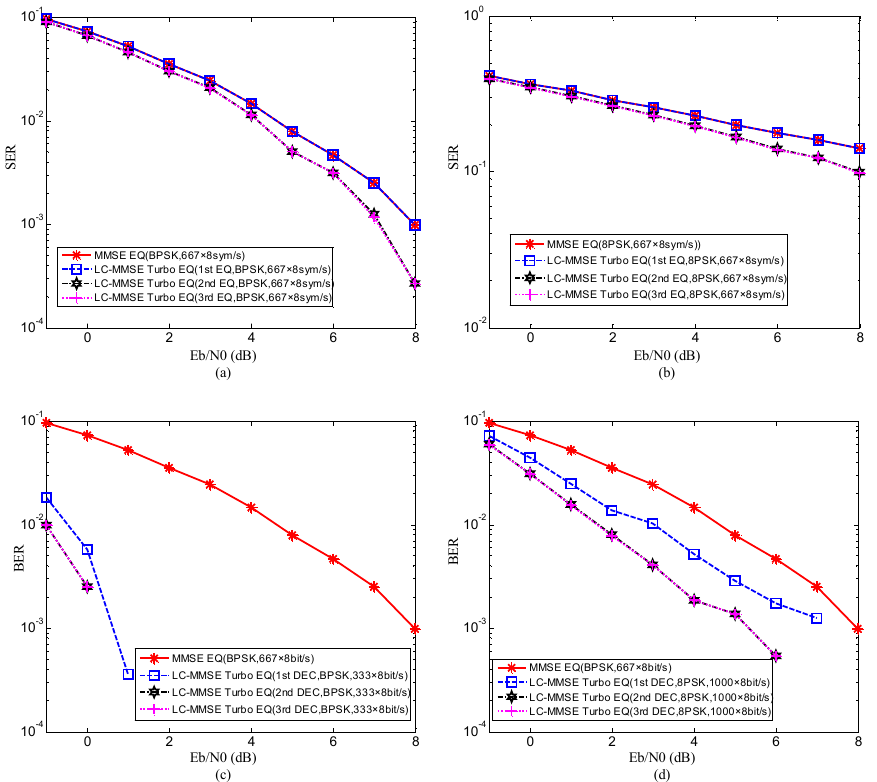
Figure 5. Simulation results of the proposed method and the method using traditional MMSE adaptive equalization: ( a ) and ( b ) the symbol error rate (SER) of low-complexity channel estimation (CE)-based MMSE equalization in the proposed method and the method using traditional MMSE adaptive equalization; ( c ) and ( d ) the bit error rate (BER) after decoding in the proposed method and the method using traditional MMSE adaptive equalization.